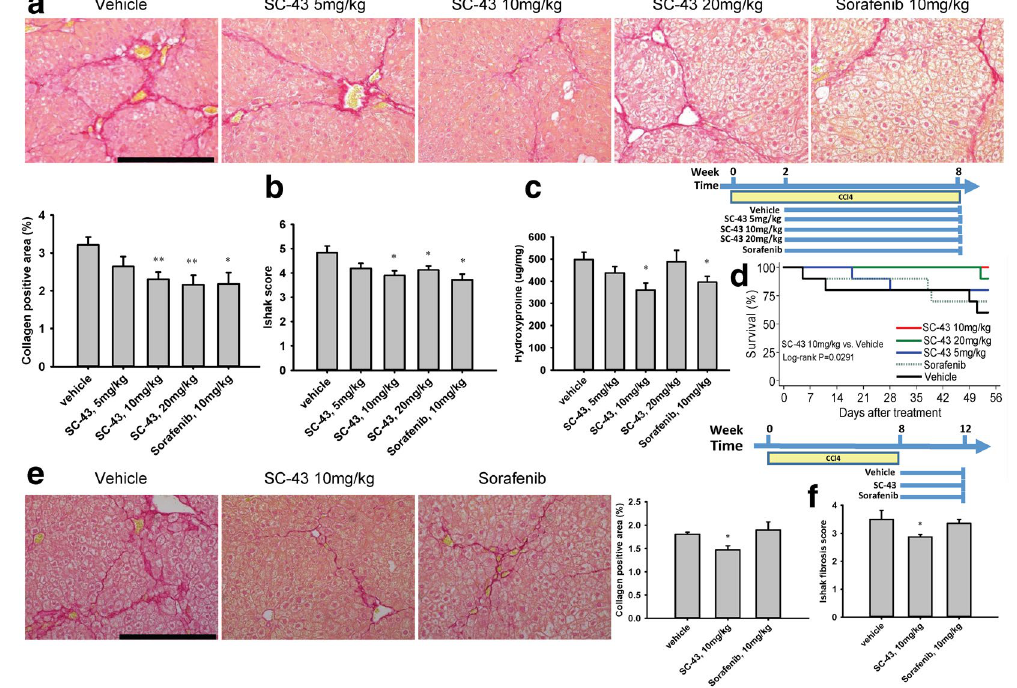
Figure 3. SC-43 treatment ameliorates liver fibrosis in the CCl 4 -induced liver fibrosis mouse treatment and regression model. In the fibrosis treatment model, following CCl 4 induction for 2 weeks, SC-43 at various dosages and sorafenib (10 mg/kg) were concurrently administered with CCl 4 for the subsequent 6 weeks. Fibrosis improved significantly after the SC-43 and sorafenib treatment. ( a ) Representative image after sirius red staining and the collagen-positive area quantification. ( b ) Ishak fibrosis score. ( c ) Liver hydroxyproline quantification. ( d ) The SC-43 (10 mg/kg) treatment improved mouse survival compared with the vehicle group (log-rank P = 0.0291). N = 6–10 in each group. In the fibrosis regression model, after CCl 4 induction for 8 weeks, SC-43 (10 mg/kg) and sorafenib (10 mg/kg) were administered for the following 4 weeks without CCl 4 . Fibrosis regressed significantly after the SC-43 treatment. ( e ) Representative image after sirius red staining and the collagen-positive area quantification. ( f ) Ishak fibrosis score. N = 6–8 in each group. Scale bar: 200 μ m. Columns: mean and bars: standard error. * P < 0.05 and ** P < 0.01 compared with the vehicle group.